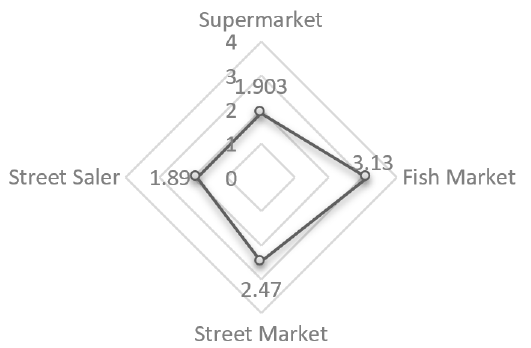
Figure 2. Fish purchase location preferences.